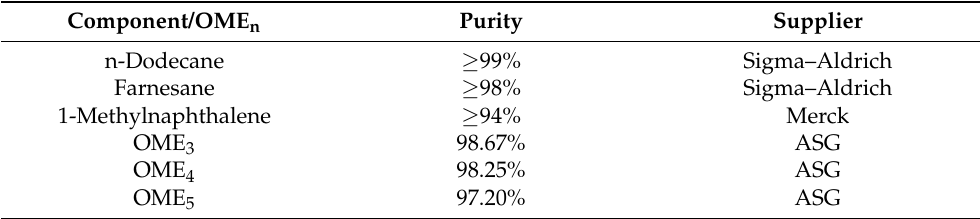
Table 1. Overview of the specific purity and supplier of the surrogate components and considered oxymethylene ether (OME n ).